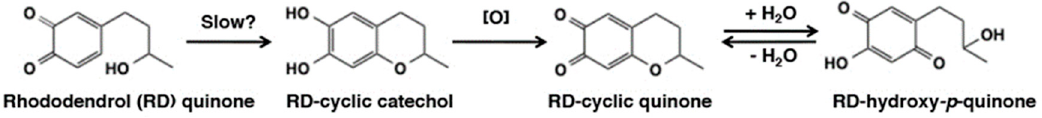
Figure 16. Reaction of rhododendrol (RD) quinone to form RD-cyclic catechol [71]. Note that this cyclization reaction is less likely to proceed [72,74].